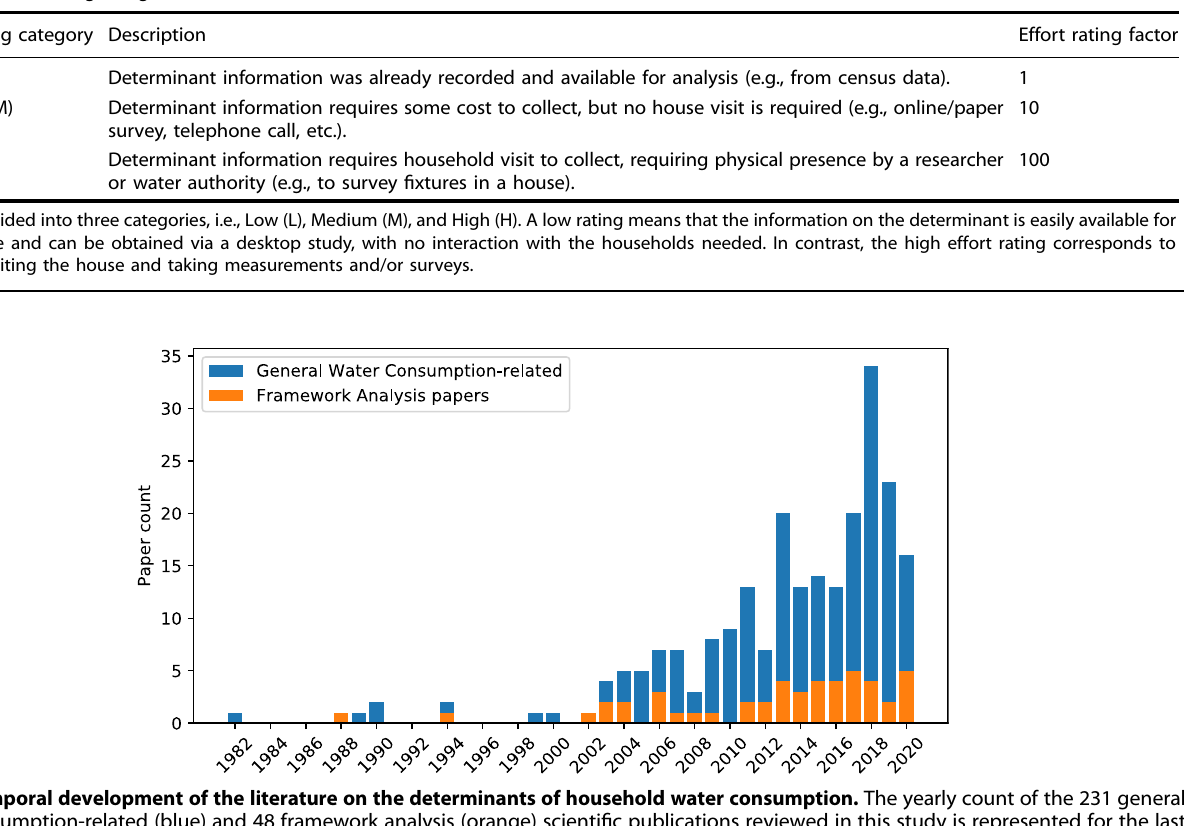
Table 4. Effort rating categories.